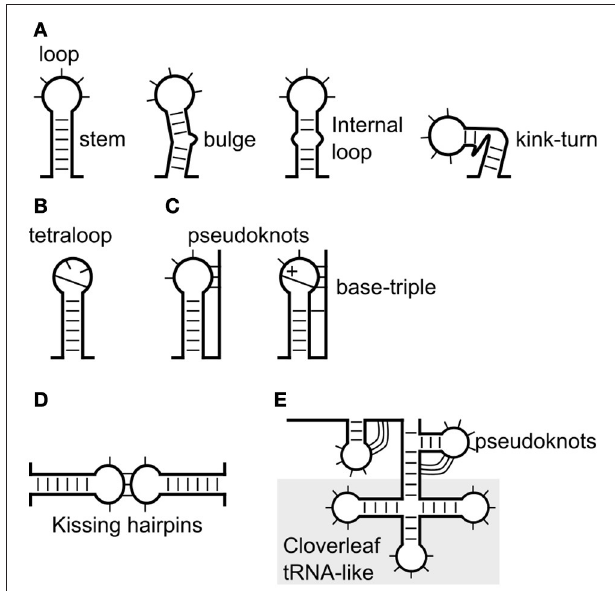
FIGURE 1 | Known viral RNA structures, from stem-loops to complex tRNA-like structures. (A) The simplest form of RNA structure is a stem-loop. A stem-loop is shown with a bulge, internal loop or (B) tetraloop. (C) The loop can also base-pair with upstream or downstream sequences to form a pseudoknot. (D) Interaction between the loops of two stem-loops forms kissing hairpins. (E) A relatively complex structure is a cloverleaf or tRNA-like structure that often consists of multiple stem-loops and